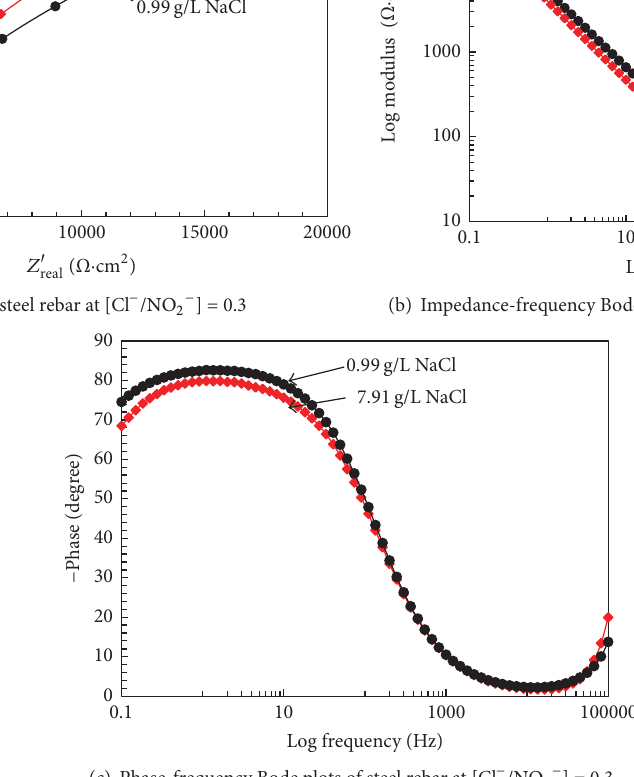
Figure 4: Electrochemical plots of steel rebar exposed in saturated Ca(OH) 2 solution with different concentrations of NaCl at [Cl − /NO 2− ] =